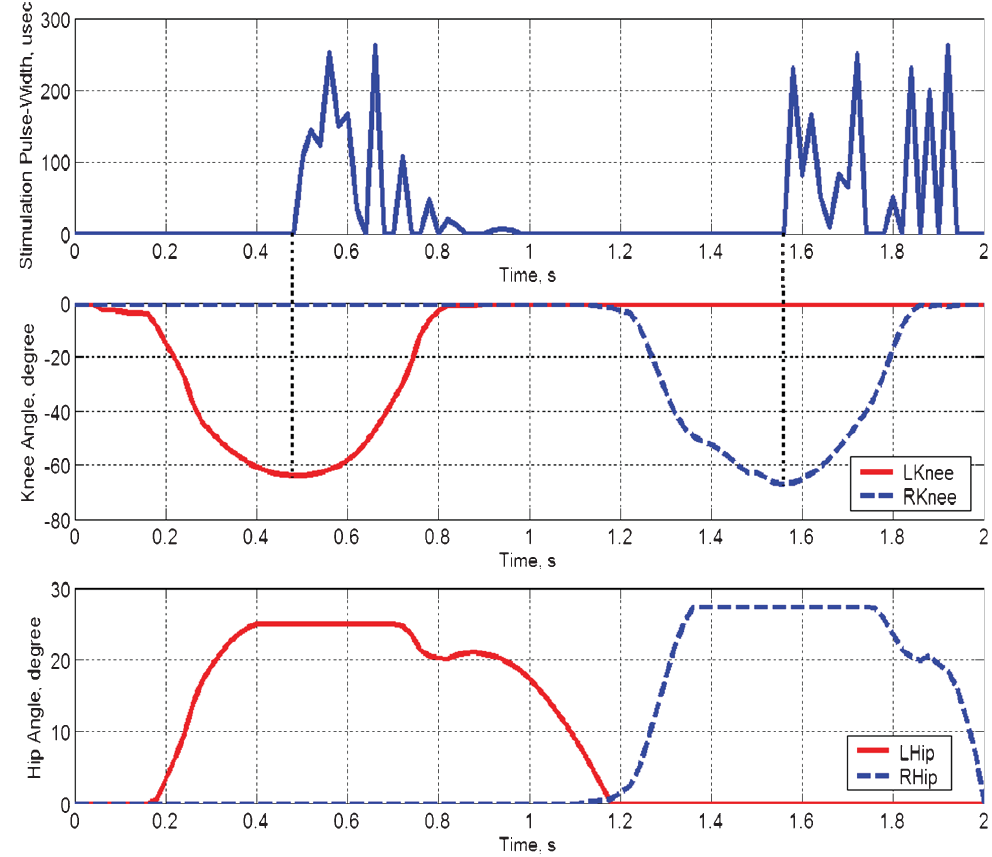
Fig. 9. Stimulation pulse-width, knee and hip trajectory for complete walking